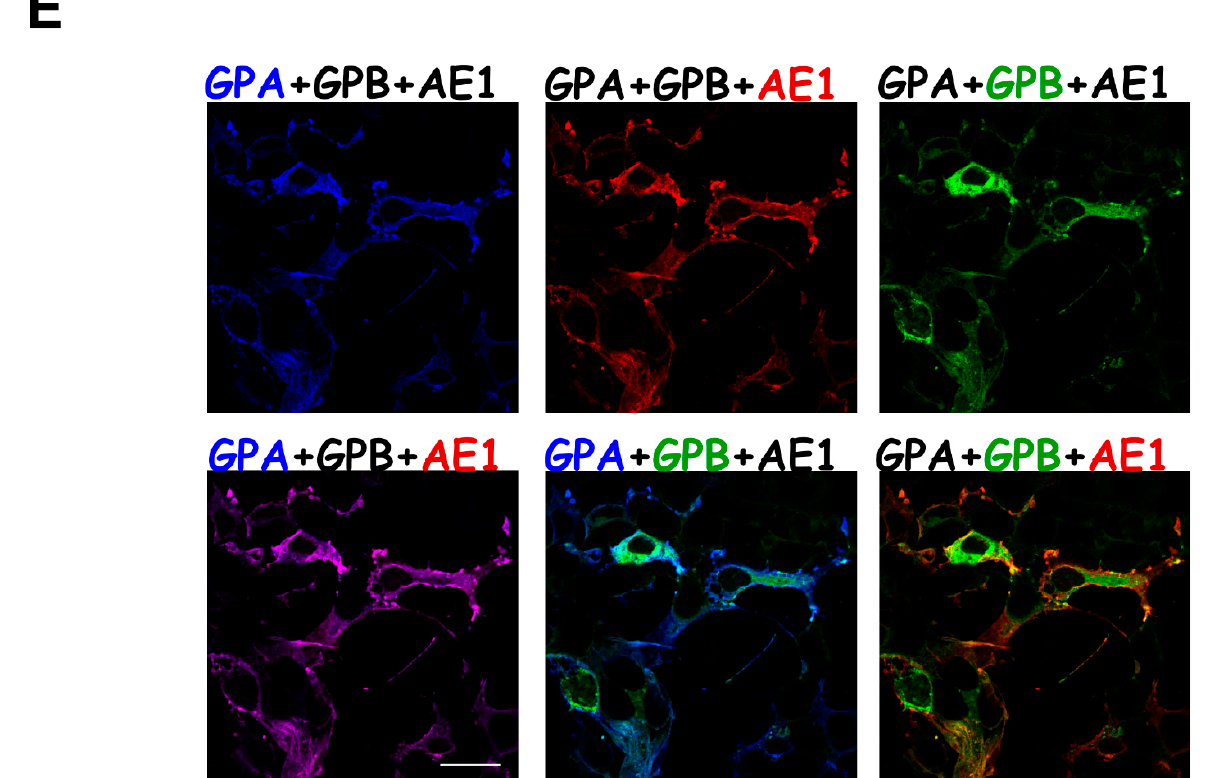
Figure 3. Confocal images revealed subcellular localization of ( A ) singly expressed AE1, GPA, GPMURgfp, and GPBgfp; ( B – D ) AE1 coexpressed with GPA, GPMURgfp, or GPBgfp in equimolar ratio; and ( E ) AE1 coexpressed with both GPA and GPBgfp in HEK-293 cells. GPBgfp and GPMURgfp fusion proteins were used for tracking, as there is no GPB- or GP.Mur-specific antibody available for immunolabeling. The transfected cells were fixed and permeabilized for immunostaining of surface and intracellular AE1 and GPA. To visualize AE1 expression, the cells were immunostained with a mix of mouse anti-AE1 mAbs (BRIC 6, BRIC 71, and BRIC170), followed by Alexa Fluor 568 or 647-conjugated anti-mouse antibody. To visualize GPA expression, the transfected cells were immunostained with Alexa Fluor 568-conjugated anti-GPA mAb BRIC163 that targets cytoplasmic GPA (absent in GPB/GP.Mur). In ( E ), HEK-293 cells were transfected with pcAE1, pcGPA and pGPBgfp (their plasmid molar ratio as 1: 1: 0.2 to mimic the relative levels in human erythrocytes). AE1 and GPA were immunostained as above. Their fluorescence signals were shown in pseudocolor: blue for GPA, red for AE1, and GPBgfp emitting green fluorescence. Scale bar = 25 μ m.